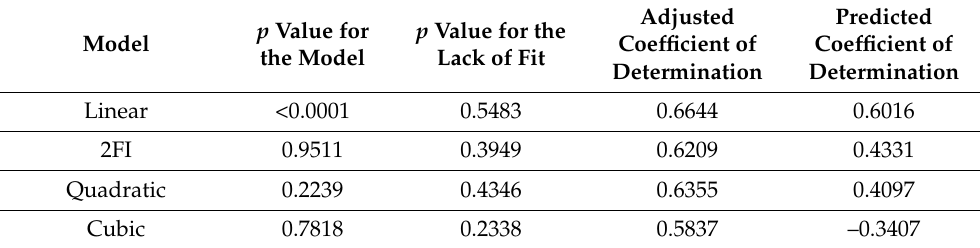
Table 8. Simulation of four models in Design Expert for notch corrosion after 480 h in the salt-spray test chamber.